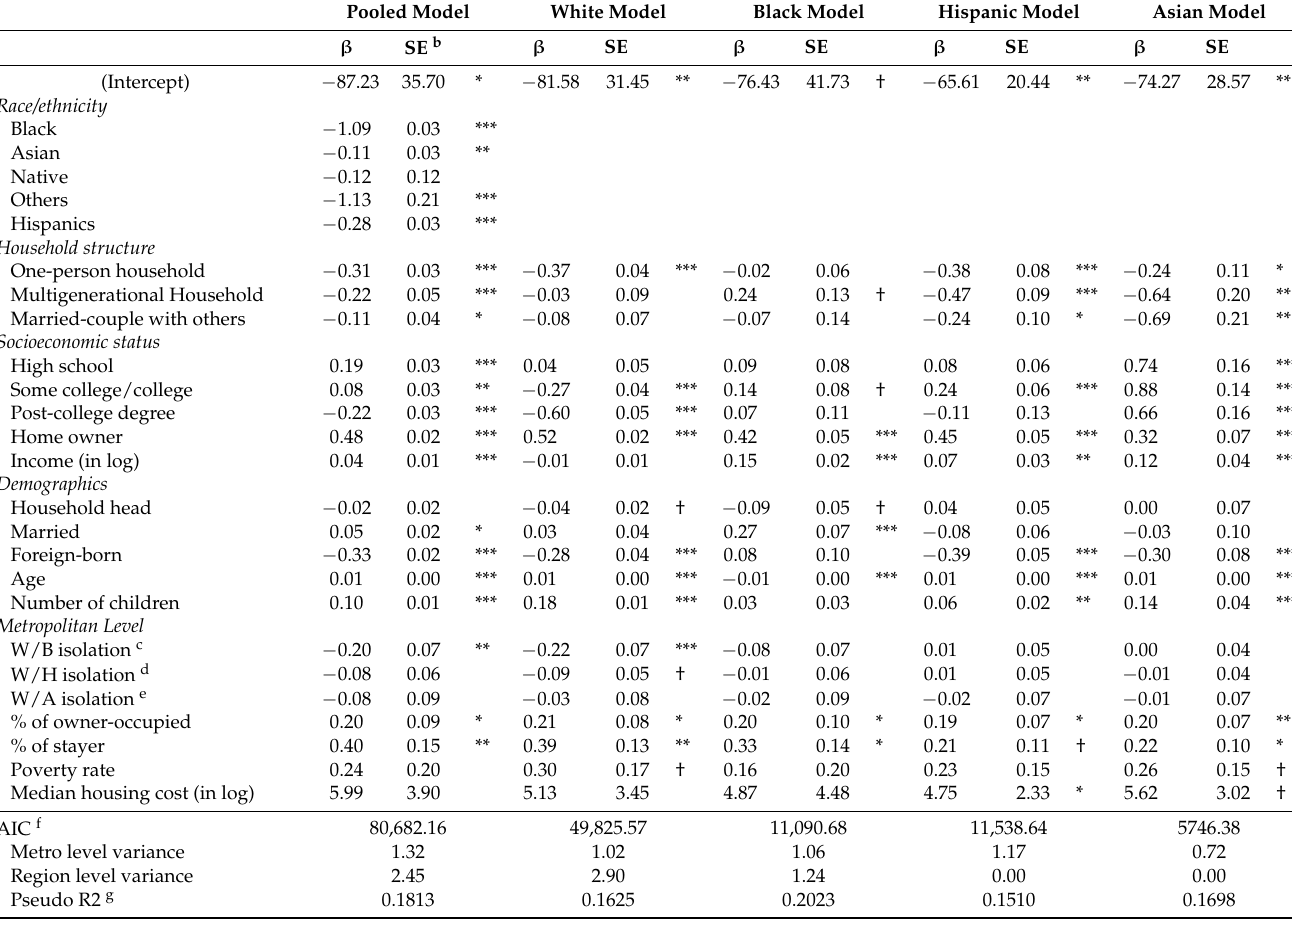
Table 3. Logistic Multilevel Modeling Results of Suburban Residence by Race/Ethnicity Groups a